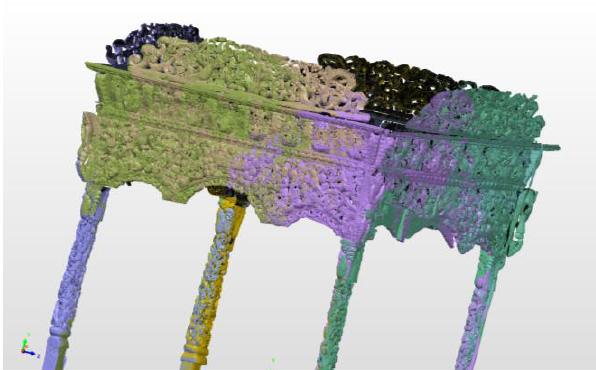
Fig. 2 The 3D point cloud produced by the